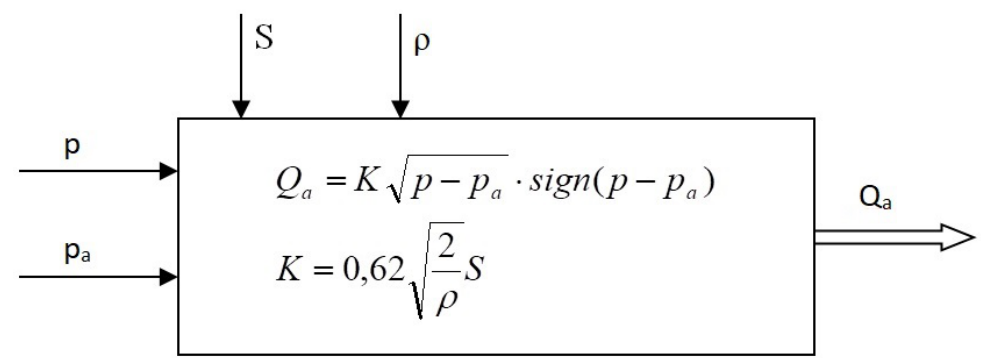
Figure 10. Block diagram of equations describing gas hydraulic accumulator displacement, where K is the hydraulic resistance, p a is the gas pressure in the accumulator, S is the cross-sectional area of the hydraulic tubes, ρ is the density of the fluid and p is the pressure in the system